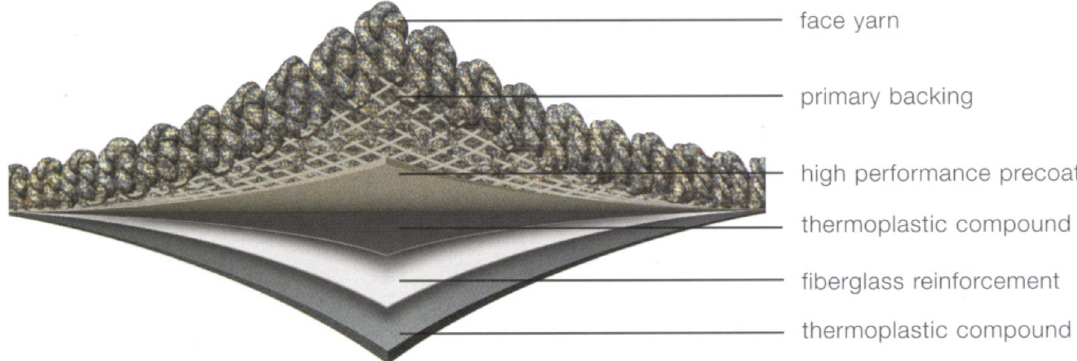
Figure 1. Schematic of the EcoWorx carpet tile [19].